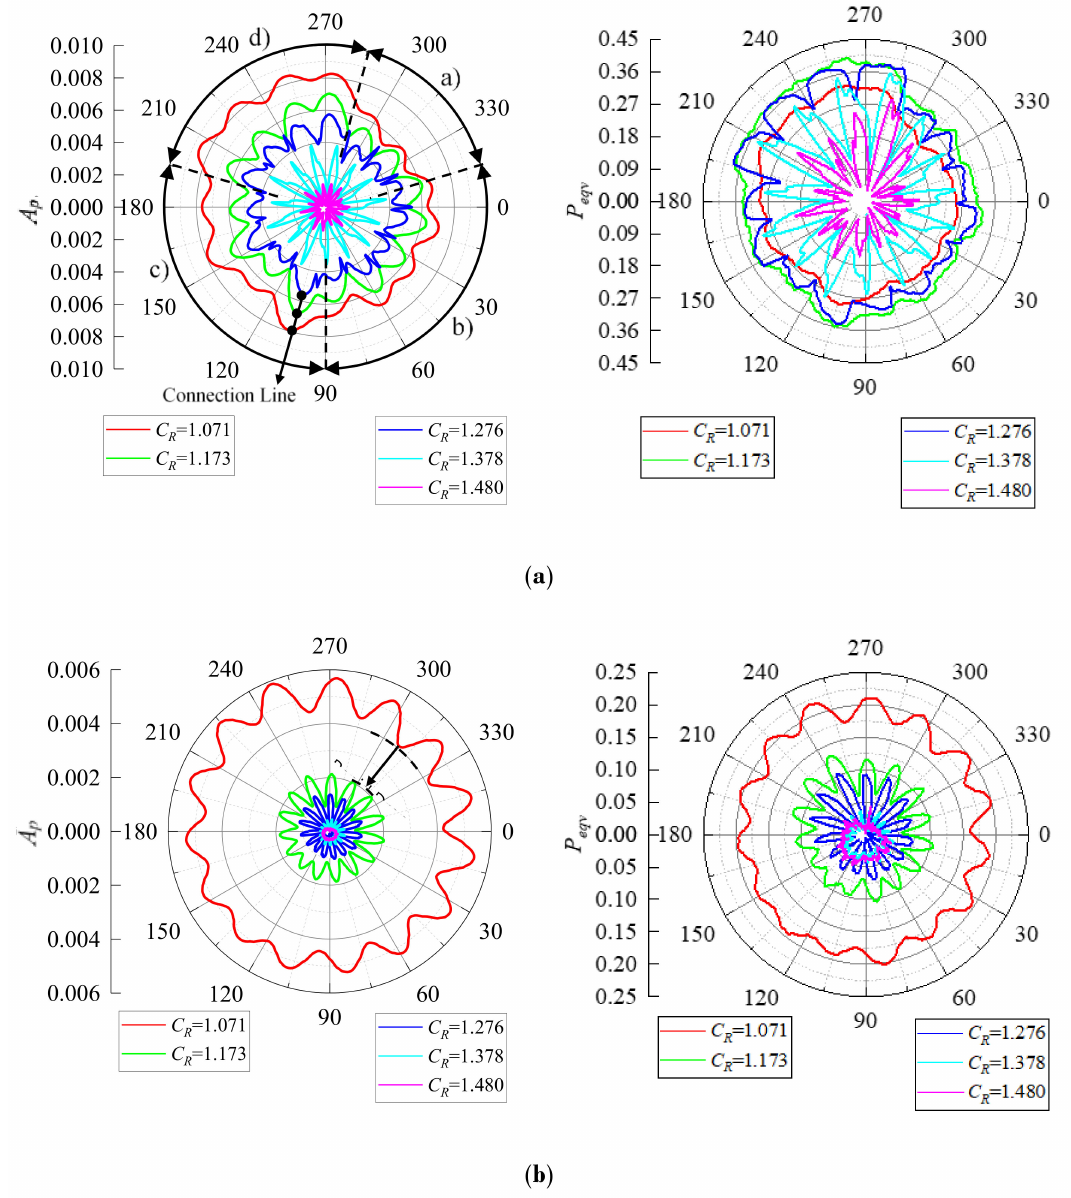
Figure 17. Circumferential amplitude of A p and P eqv distribution. ( a ) 140 Hz; ( b ) 280 Hz. The absolute amplitude A p and relative amplitude P eqv on the ISO- C R circles from θ = 0 degree to 360 degrees are shown in Figure 17. Figure 17a,b are about the BPF and its second harmonic frequency. The circumferential variation law of A p and P eqv are similar. In total, 15 (vaned diffuser blade number) periods can be seen at different C R positions.